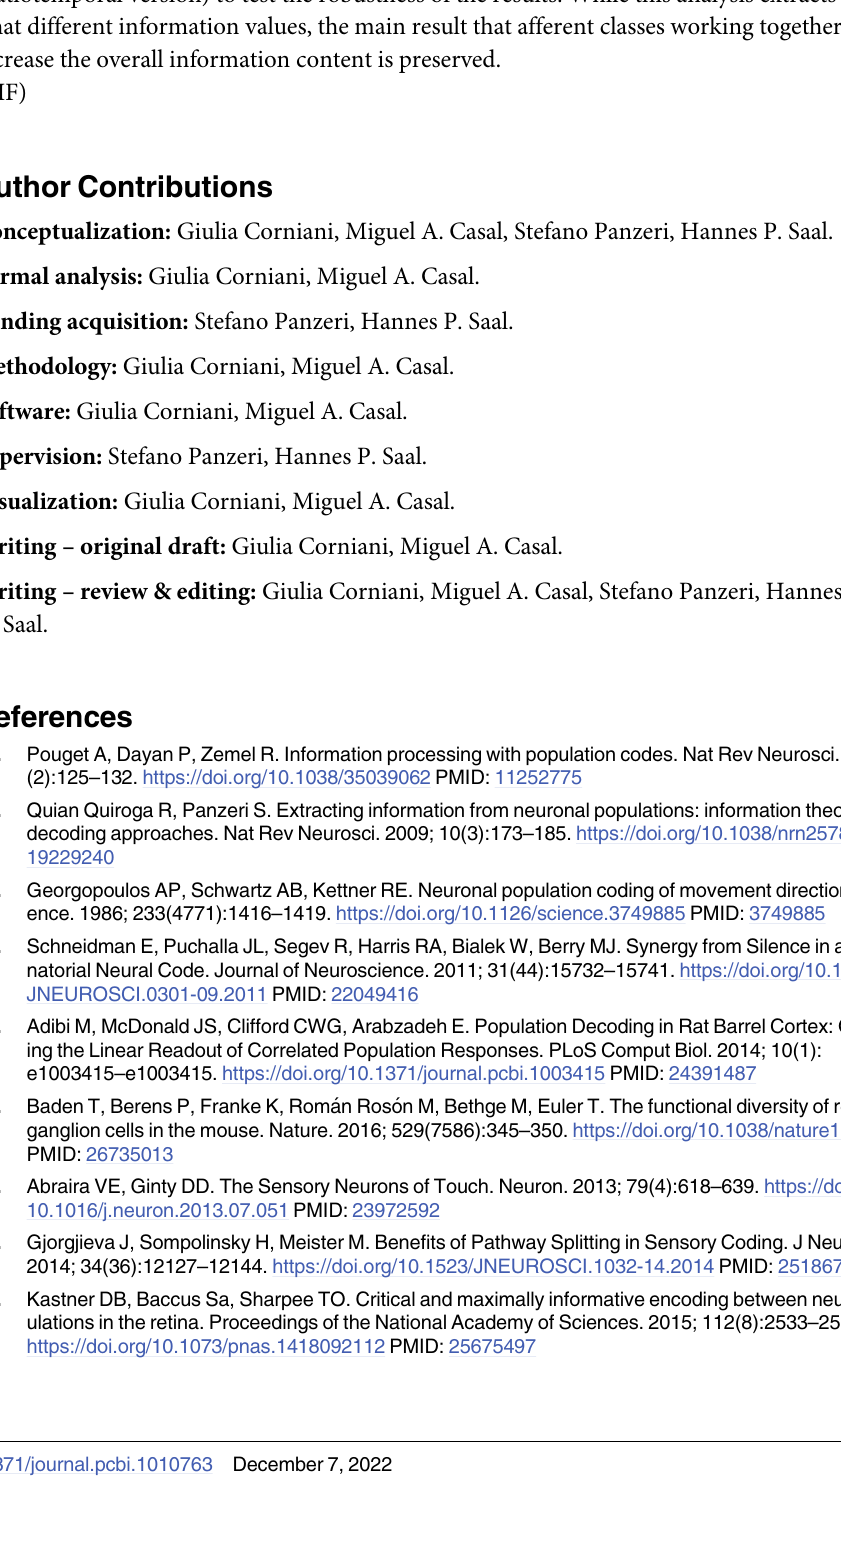
S2 Fig. Robustness of findings using a spatial NMF decomposition of neural responses. The analysis presented in Fig 5A (panel iv) was redone using a spatial NMF (rather than the spatiotemporal version) to test the robustness of the results. While this analysis extracts some- what different information values, the main result that afferent classes working together increase the overall information content is